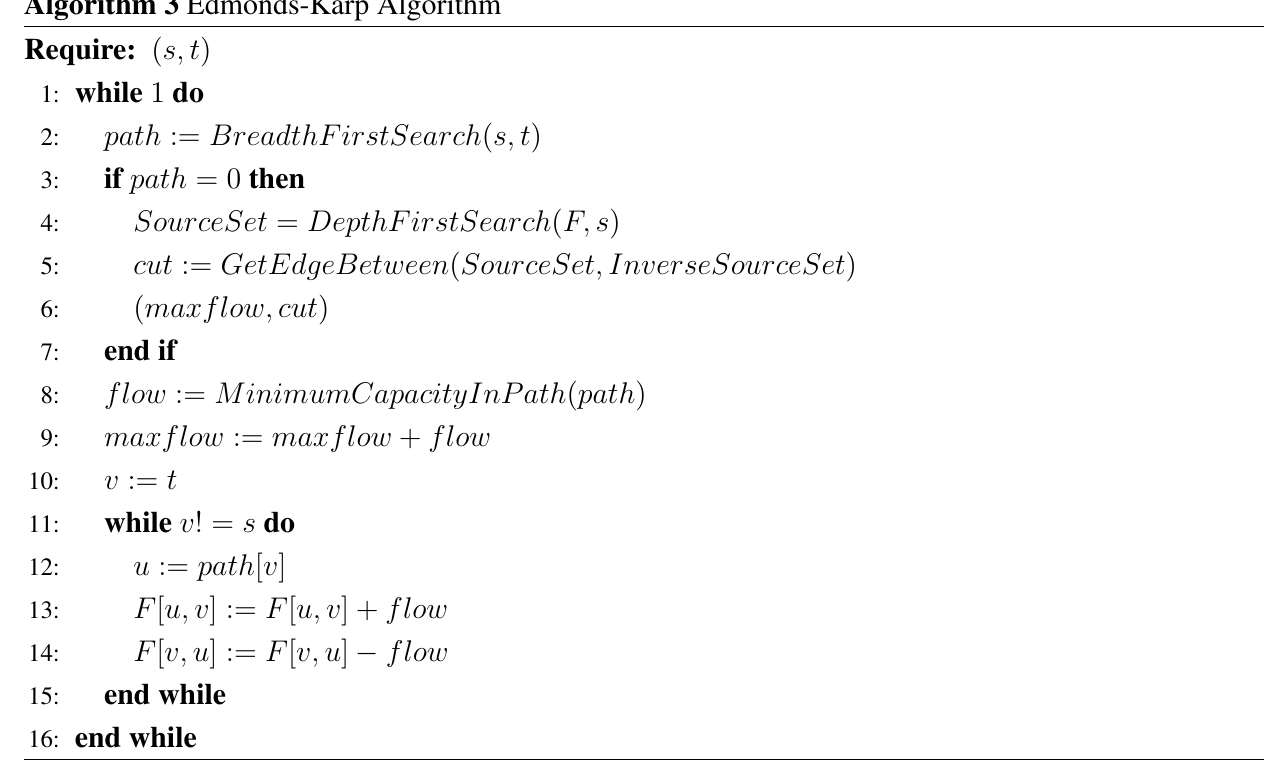
Algorithm 3 Edmonds-Karp